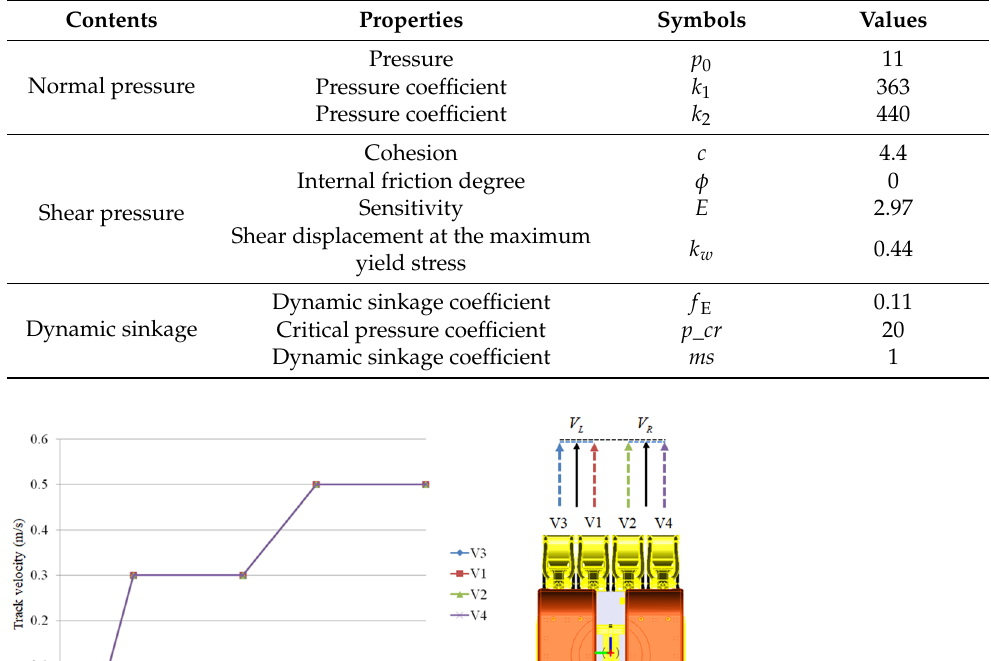
Table 4. Properties of soft soil.